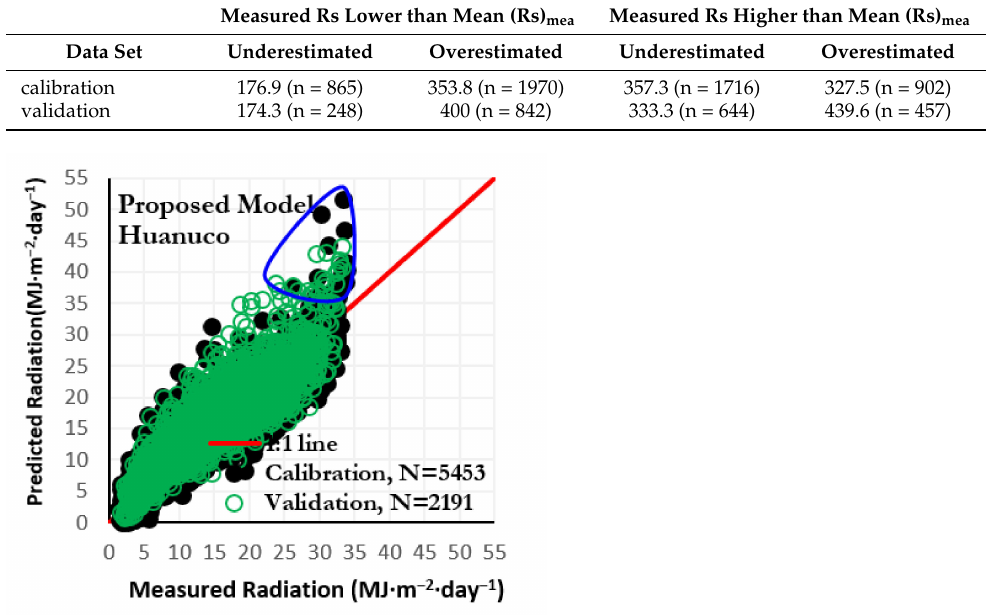
Figure 6. Solar radiation estimated by proposed model at Huanuco station versus measured values in calibration and validation sets.